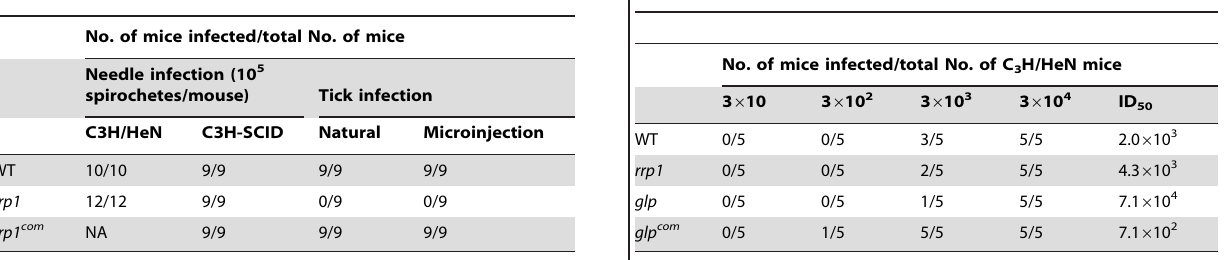
Table 2. Mouse infectivity of the rrp1 mutant. No. of mice infected/total No. of mice Needle infection (10 5 spirochetes/mouse)